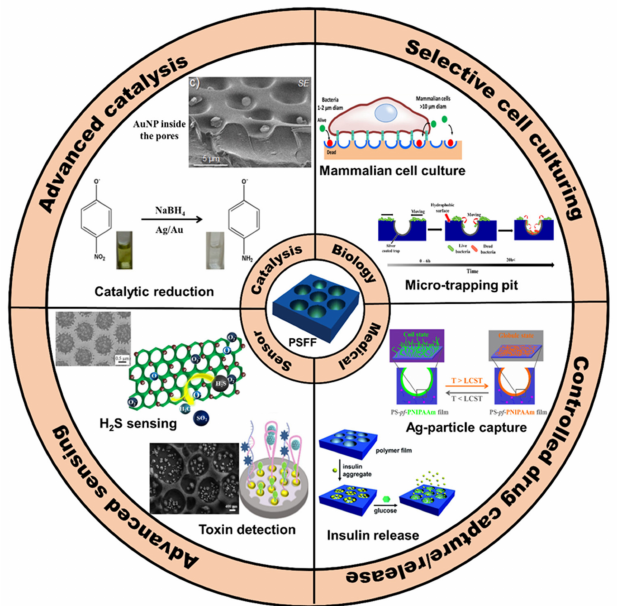
Figure 21. Pore-selectively functionalized HCP films via the modified BF method and their applications in biology, medical, sensor application, and catalysis. PSFF—Pore-Selectively Functionalized